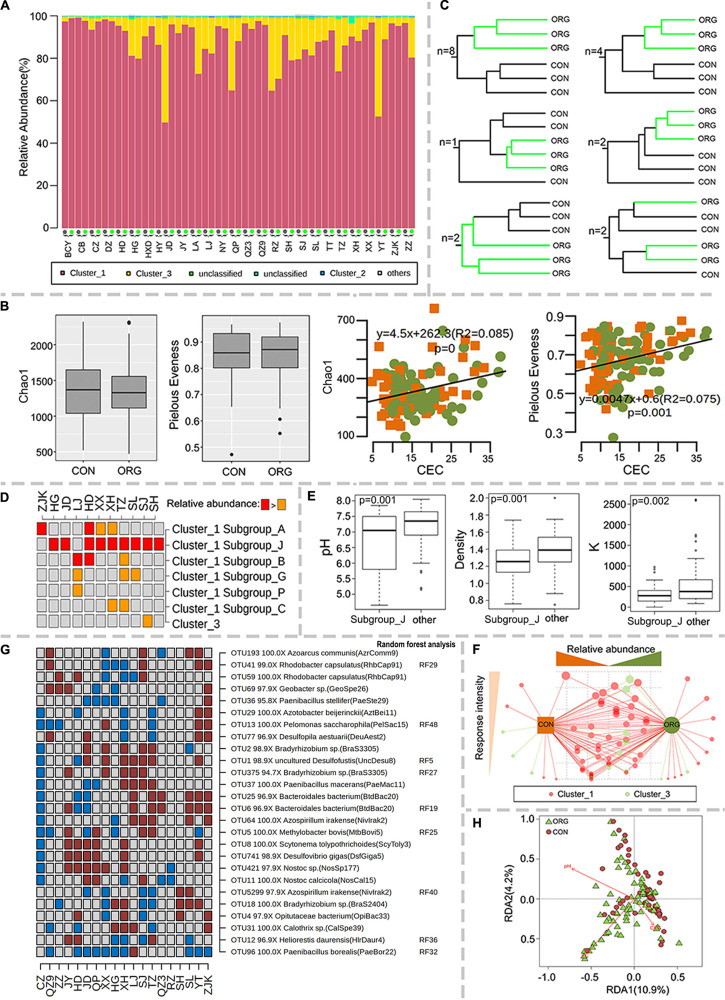
Association of the diversity of diazotrophic populations with the farming system. (A) Relative abundance of major nifH gene clusters, (B) Chao1 and Pielou’s evenness indexes and their correlations with CEC; green dots and orange squares indicate organic and conventional farming, respectively. (C) Number of sites with the schematic UPGMA cluster. (D) Discriminative subgroups of nifH genes. (E) Boxplot of differences in pH, density and K levels between the sites with increased and non-increased relative abundance of subgroup J of nifH cluster 1. (F) The association of each diazotrophic OTU with the farming system. The size of the dots indicates the frequency of each OTU to be discriminative between farming systems. The tendency of each OTU to organic or conventional farming systems was indicated by their distance to farming systems. (G) Discriminative diazotrophic OTUs between farming systems ranked in the 50 most influential OTUs. Brown and cyan squares indicate significantly (p < 0.05) higher or lower relative abundance in the ORG than in the CON, respectively. Gray squares indicate no significant difference between farming systems. (H) Redundancy analysis (RDA) of soil characteristics and diazotrophic microbial communities. ORG, organic farming system; CON, conventional farming system.